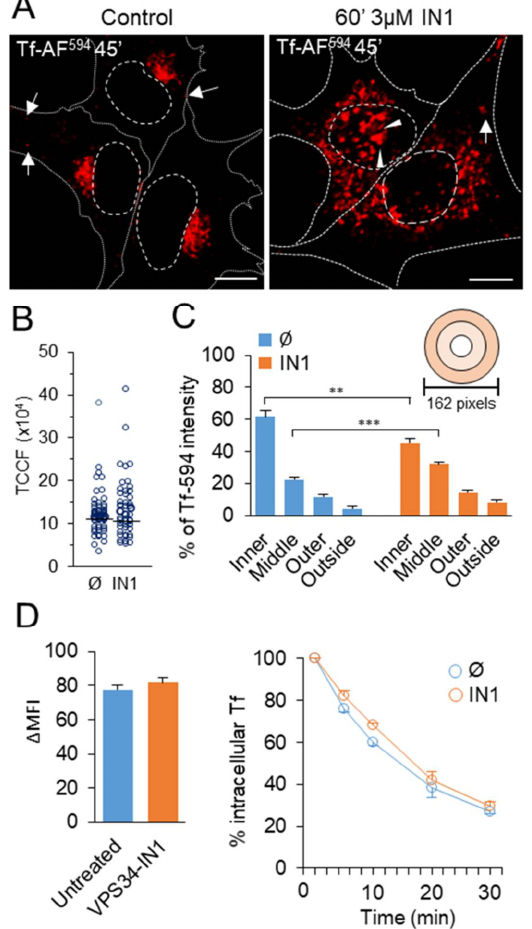
Figure 2. PI3P depletion reorganizes the early endosomal recycling circuit. Balb 3T3 cells were treated with either 3 μM VPS34-IN1 (IN1) or tissue culture medium containing DMSO (control) for 60 min and incubated with either Tf-AF 488 or Tf-AF 594 for 45 min in the presence of the inhibitor. ( A ) Representative confocal images ( n = 8) of internalized Tf-AF 594 . Cell borders are indicated by fine dotted lines and cell nuclei by fine dashed lines. Bars, 10 μm. ( B ) Quantification of intracellular Tf- AF 594 by Fiji analysis of images. The dots represent the TCCF of individual cells in the representative experiment ( n = 4). ( C ) Quantification of Tf-AF 594 distribution using Fiji. Concentric circles (0–54, 55– 108, and 109–162 pixel distance) were centered on the area with the highest fluorescence signal. The intensity of Tf-AF 594 within the circles was quantified relative to the total intensity in the whole cells. Data represent mean ± SEM; *** p ˂ 0.001, ** p ˂ 0.01 (one-way ANOVA). ( D ) Pulse-chase analysis of TfR recycling. Cells were pulsed with Tf-AF 488 , chased in a medium containing unlabeled Tf, and intracellular fluorescence quantified by flow cytometry. Fluorescence intensities (ΔMFI) after a 45 min pulse are shown on the left, and the kinetics of loss of intracellular fluorescence by TfR recycling is shown on the right. Data represent mean ± SEM from three independent experiments.